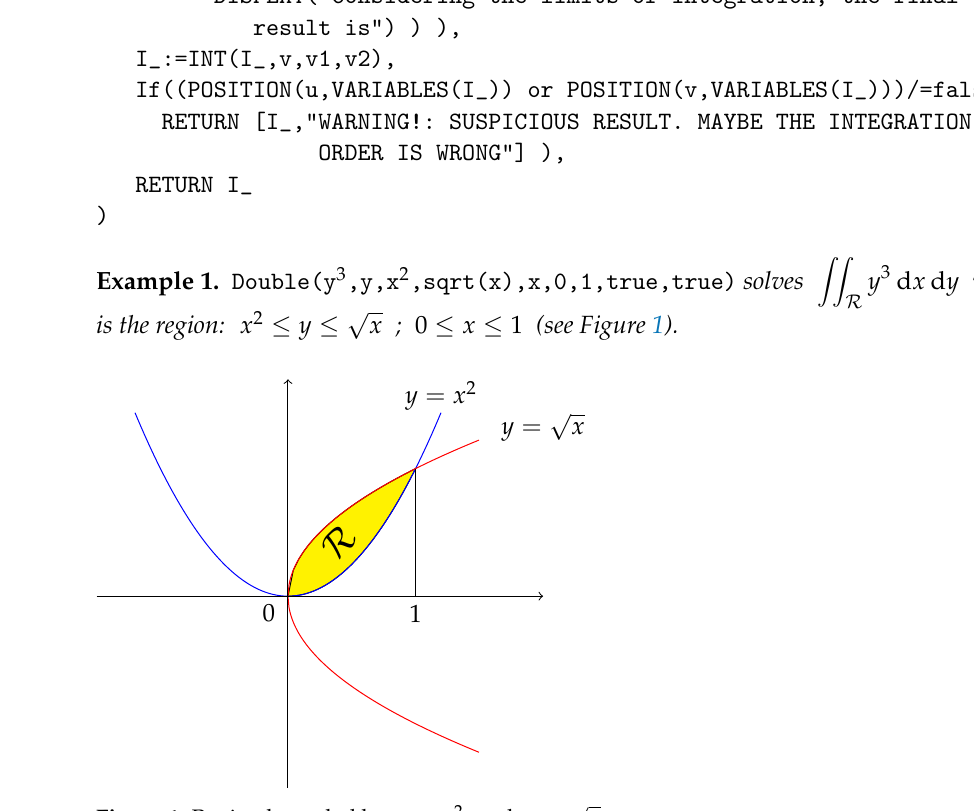
Figure 1. Region bounded by y = x 2 and y =